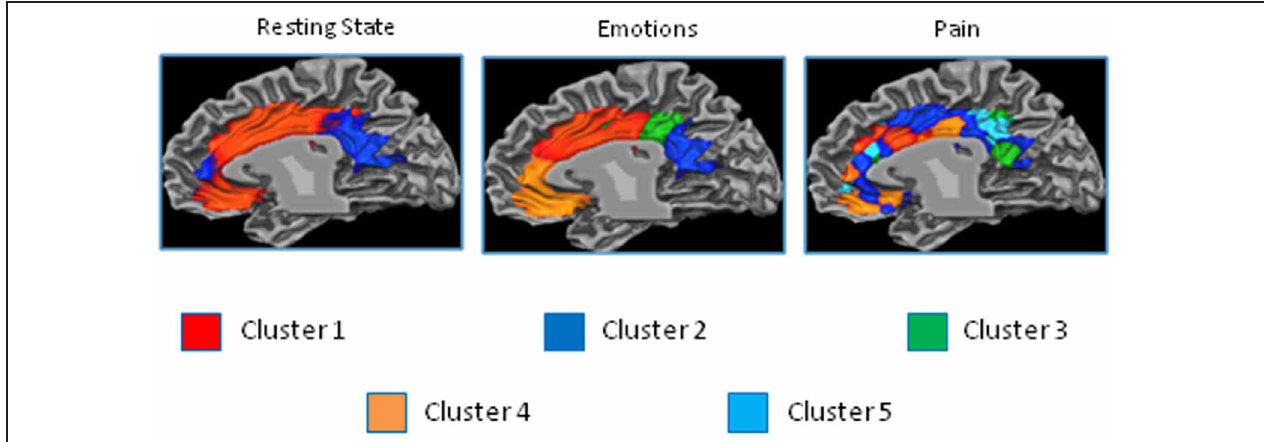
FIGURE 9 | Control experiments. Connectivity-based parcellation of the cingulate cortex in the three datasets. Probabilistic maps for functional connectivity defined clusters. The color scheme represents the probability of overlapping brain areas in each voxel across all